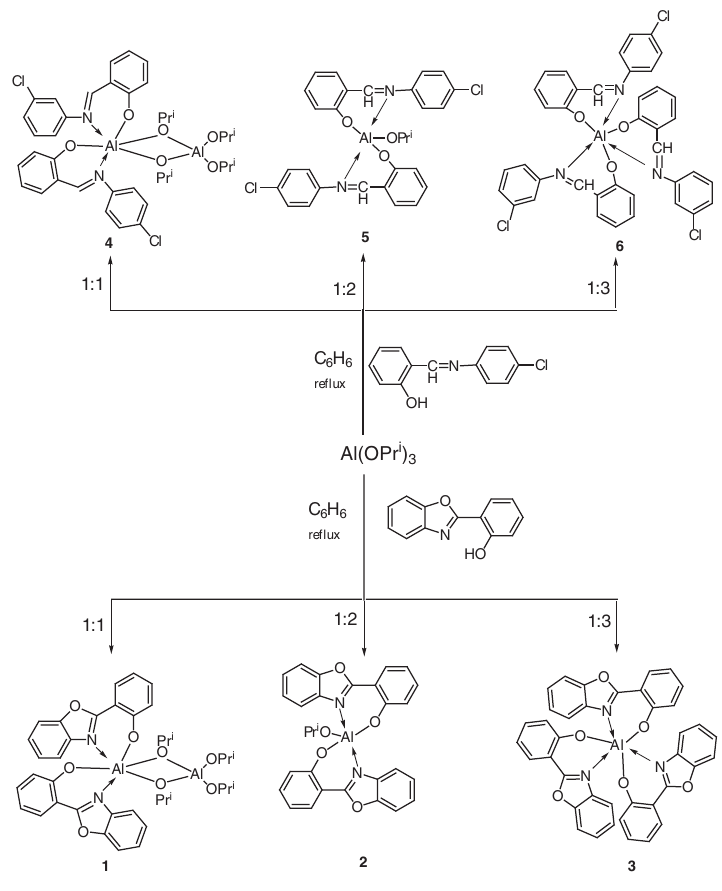
Scheme 1: Synthetic route for preparation of aluminium(III) complexes. Table 1: Synthetic and analytical details of Al(III) complexes 1 – 6